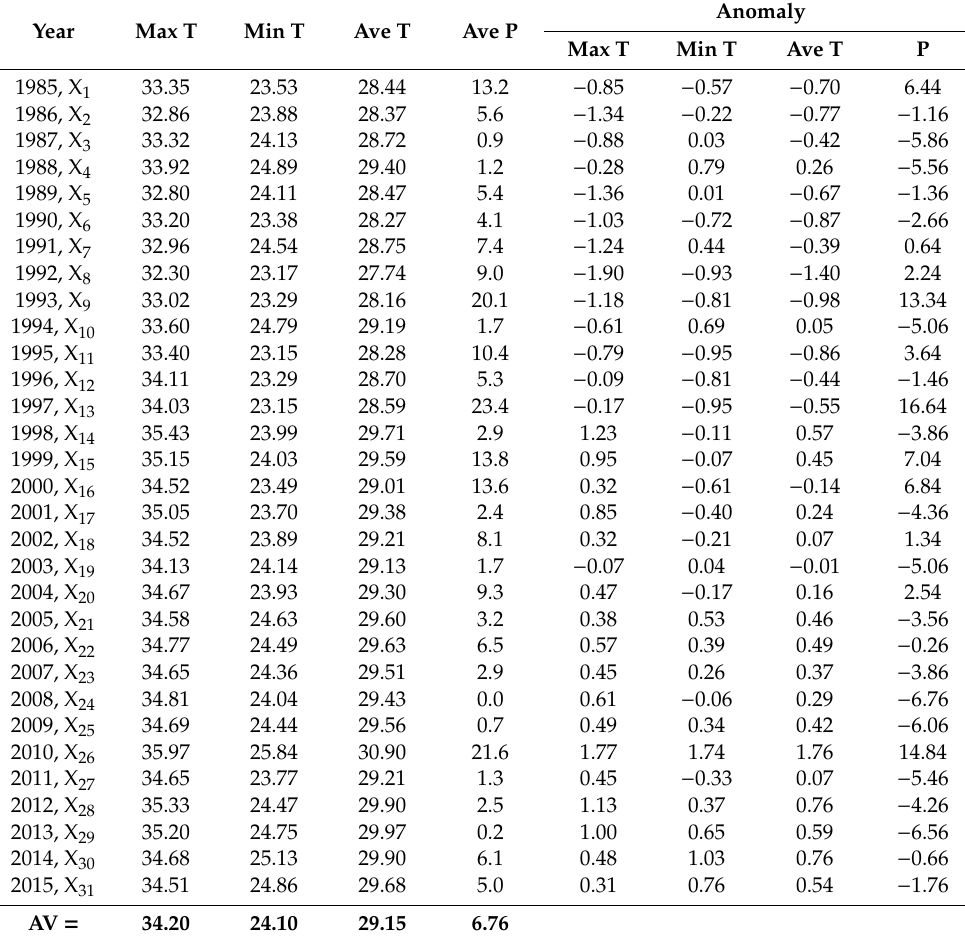
Table 3. Precipitation anomalies from 1985 to